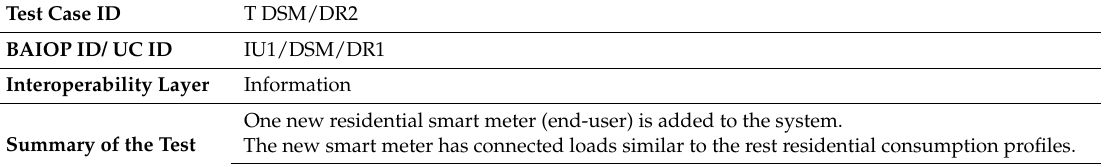
Table 11. BAIOP for the information